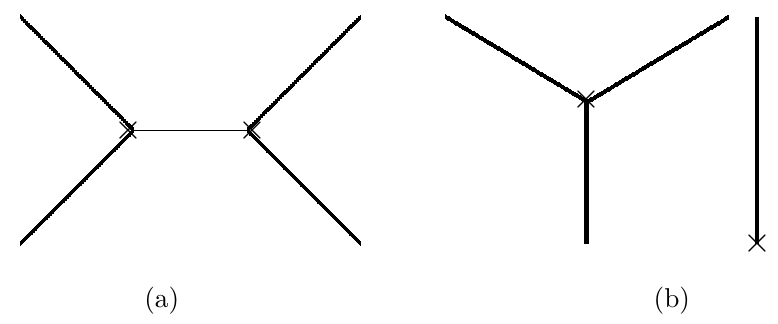
Figure 2 . Examples of amplitudes in the original open closed string field theory on a single D- instanton that become part of the interaction vertex of the closed string effective field theory. The thick lines represent closed string propagators, the thin lines represent open string propagators and the × ’s denote D-instanton type interaction